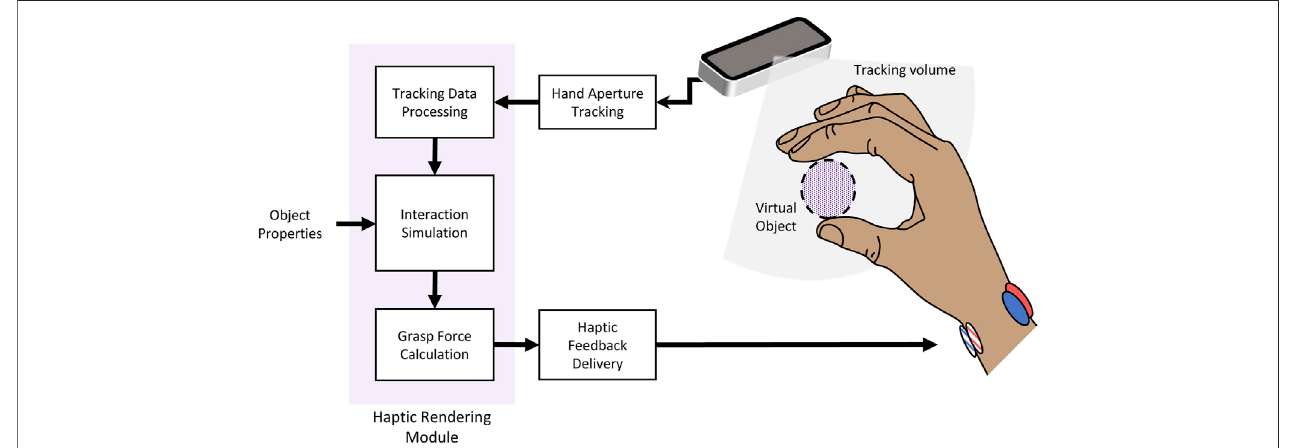
FIGURE1| xTouch:aneuro-hapticfeedbackplatformforvirtualobjectinteraction.Duringvirtualobjectexploration,measurementsofhandapertureareusedbya hapticrenderingmodulewithinformationfromanobjectpropertiesdatabasetocalculateforcesresultingfromuserinteraction.Thehapticfeedbackpro fi lesaremapped to determine parameters of the stimulation delivered by the neurostimulation